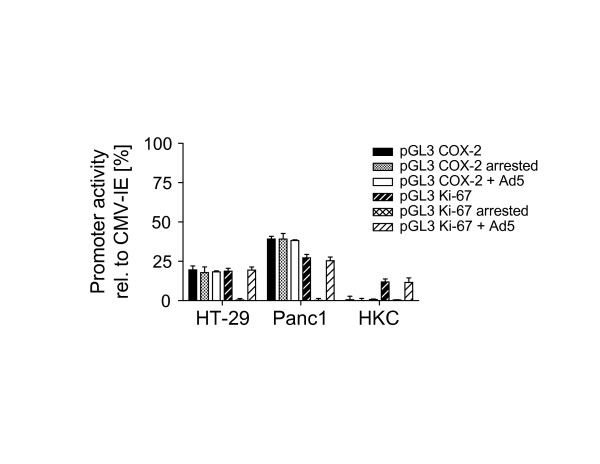
Luciferase reporter assays. The specificity of the COX-2 and Ki-67 promoter was confirmed using a dual luciferase reporter assay, allowing the analysis of test promoters via firefly luciferase activity and normalization of transfection efficiency via Renilla reniformis luciferase driven by the constitutive CMV-IE promoter in a single-well. Promoter activity was measured in subconfluent or G0/G1-arrested cells. To examine whether adenoviral gene products influence the promoter activity cells were infected with Ad5 after transfection with the reporter plasmids. The activity of the COX-2 and Ki-67 promoter was normalized to that of the CMV-IE promoter. Data are presented as mean ± SD from four independent experiments.